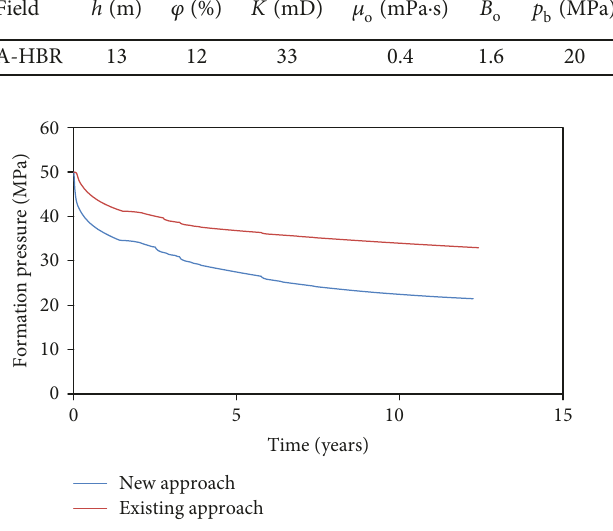
Figure 8: Formation pressure comparison of the existing approach and the new